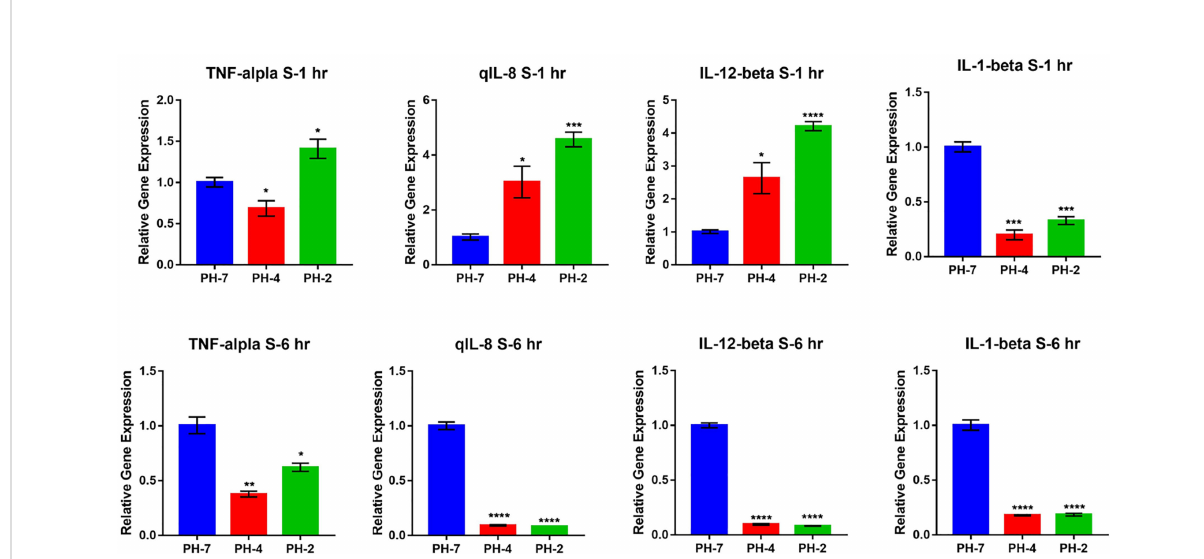
FIGURE 7 O. niloticus cultured in at pH 5, 6, and 7 for 2 weeks. Histograms showing relative immune gene expression. * means p < 0.05, ** means p < 0.01, *** means p < 0.005, **** means p <